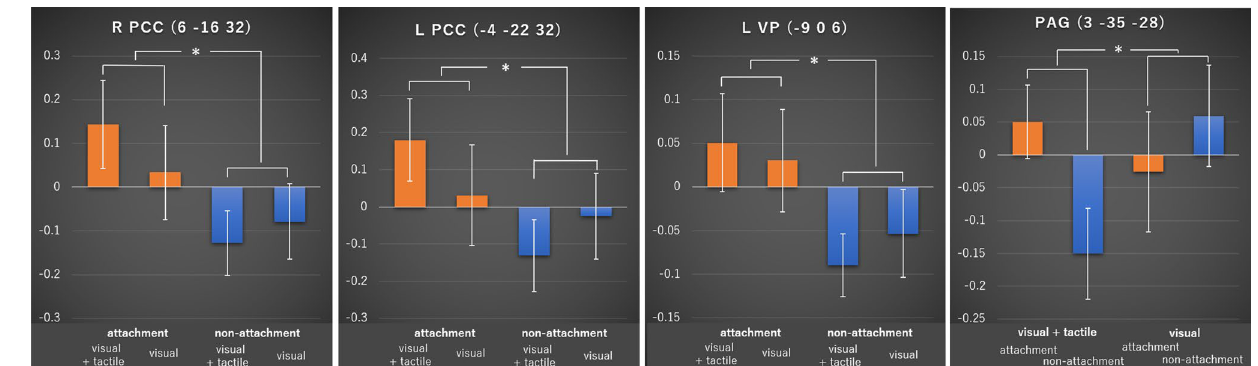
Figure 2. Results of the ANOVA. The left posterior cingulate cortex (PCC; − 4, − 22, 32), right PCC (6, − 16, 32), and left ventral pallidum (VP; − 9, 0, 6) demonstrated the main effect of attachment. The PAG (3, − 35, − 28) showed an interactive effect. p < 0.05. PCC, posterior cingulate cortex; VP, ventral pallidum; PAG, periaqueductal